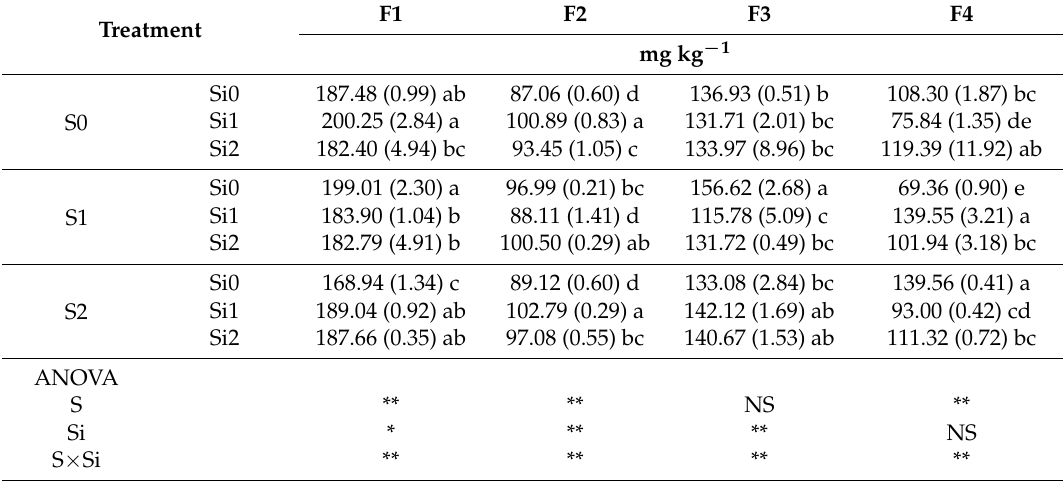
Table 2. Effect of sulfur and silicon additions on soil copper speciation. Standard errors of means are given in parentheses.